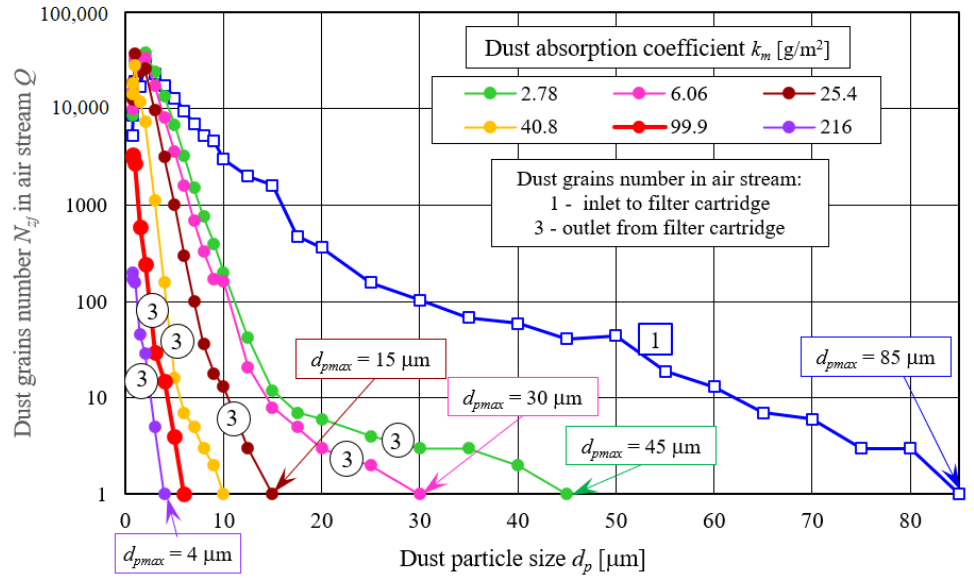
Figure 11. Dust grains number in inlet stream to cyclone (1) and outlet stream from filter element (3) in individual size ranges for different dust absorption coefficient ( k m ) values during filter element A tests (cellulose) working without cyclone.